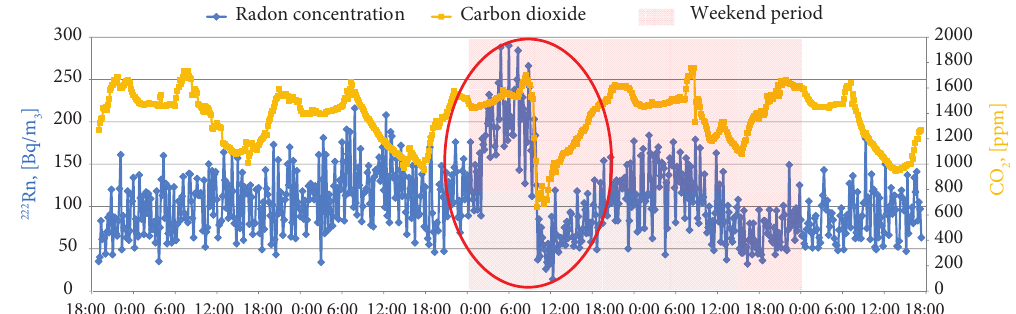
Figure 8. Indoor radon and carbon-dioxide concentration in 2016 winter at Gö1 house in case of 5 day